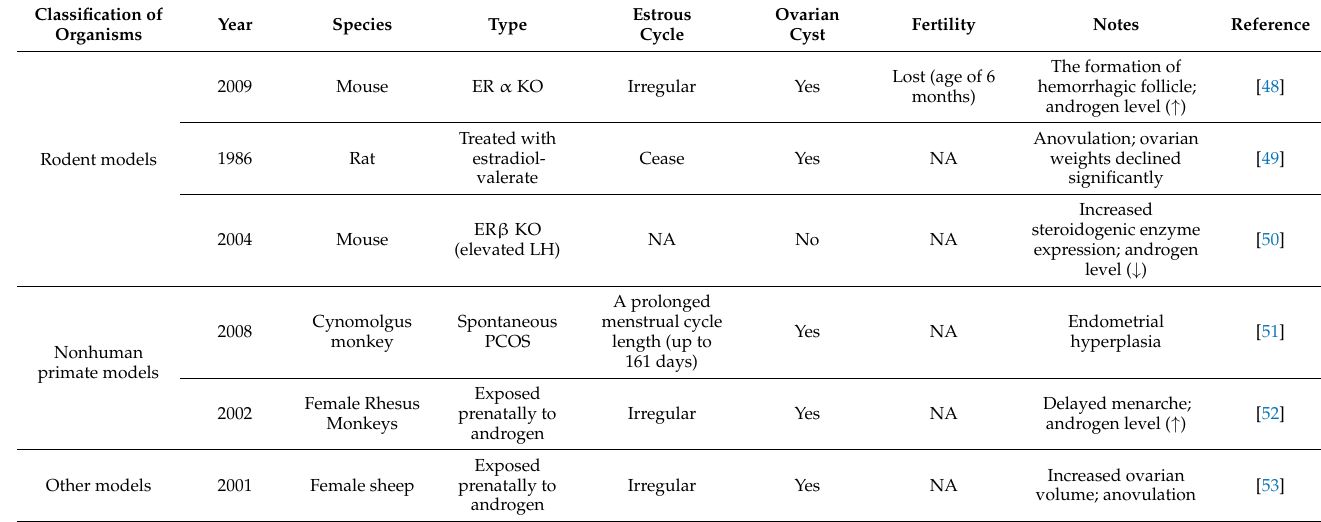
Table 1. The symptoms of polycystic ovary syndrome (PCOS) caused by changes in the endocrine systems of animal models. Classification of